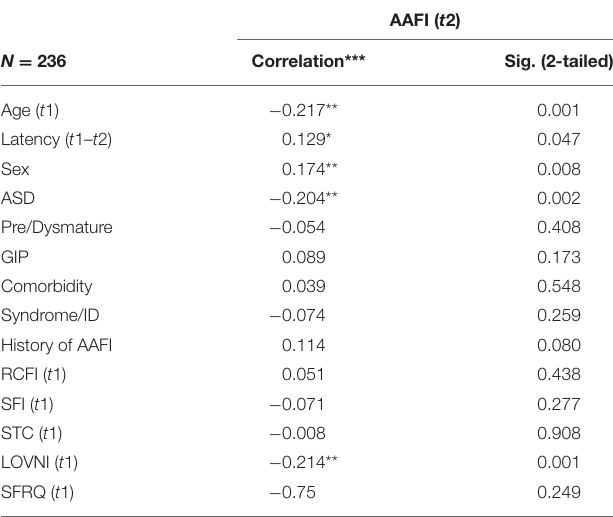
TABLE 3 | Correlations between t 1 measures and age-appropriate food intake (AAFI) at t